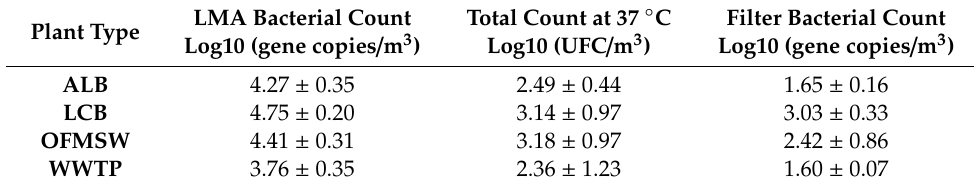
Table 3. Bacterial count data summarized in relation to plant type: mean and standard deviation of bacterial quantification from Low Melting Agarose (LMA) and filters and total mesophilic bacteria count.